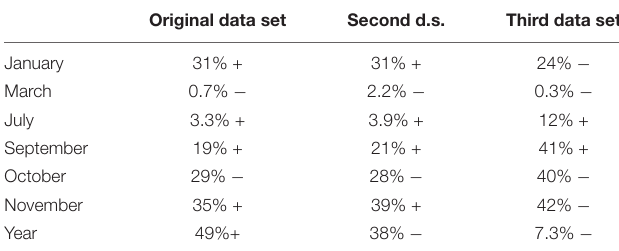
TABLE 8 | Dependence on network density. Mann-Kendall trend test results. Original data set Second d.s. Third data